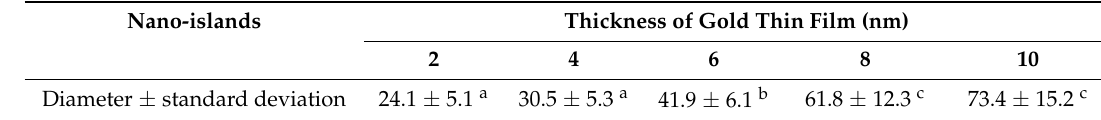
Averages that have different lowercase letters are significantly different ( p < 0.05).